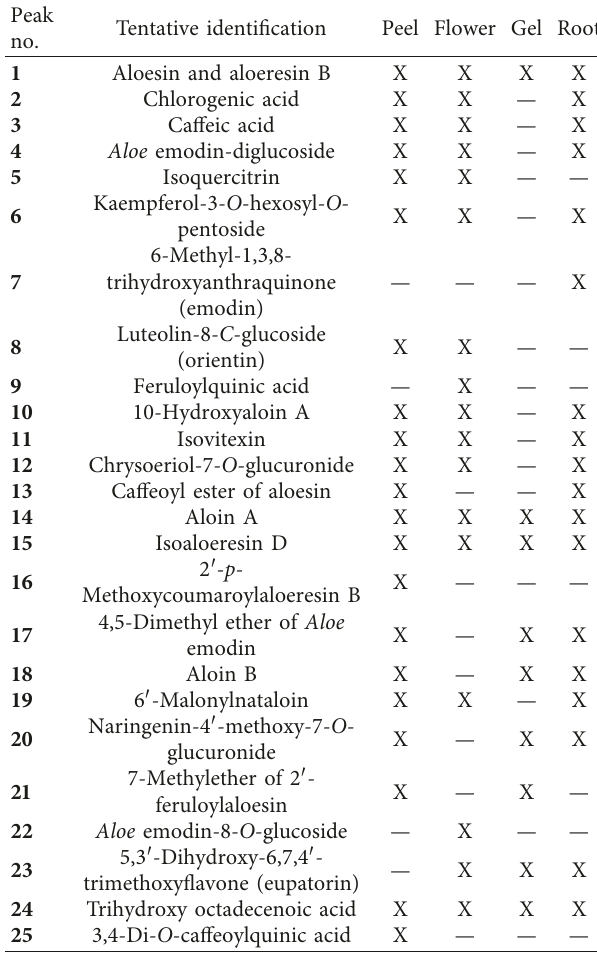
Table 3: Distribution of the phenolic compounds identified ten- tatively in methanolic extract of peel, flower, gel, and root from Chilean A. vera . Peak Tentative identification Peel Flower Gel no.